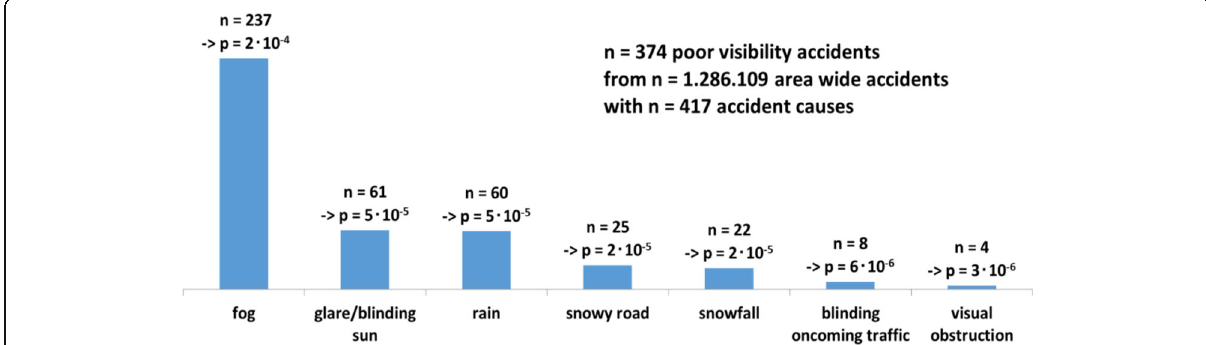
Fig. 9 Distribution of 374 accidents in Saxony involving fog, glare, rain and